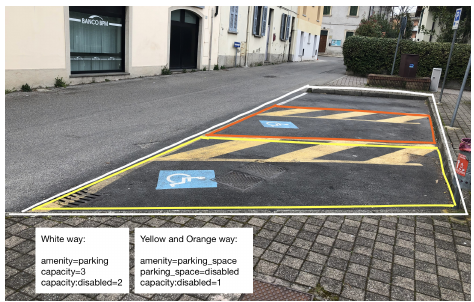
Figure 4. Example of mapping the parking spaces reserved for people with